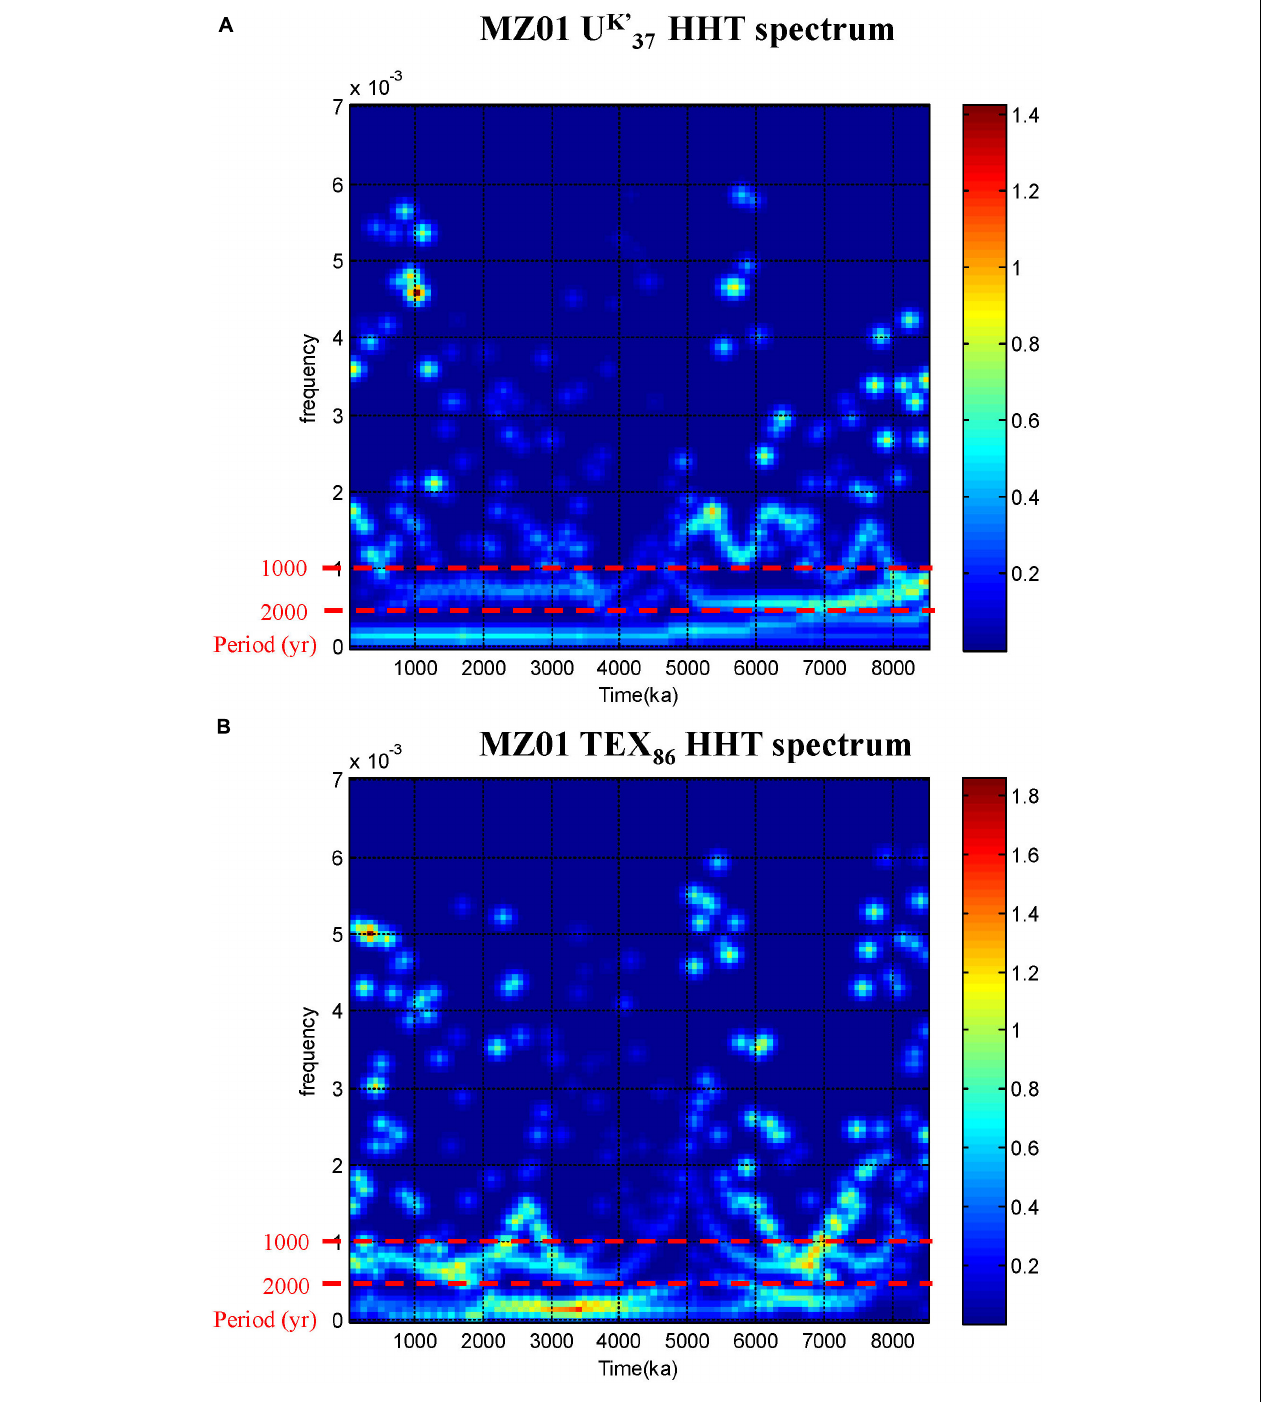
FIGURE 4 | HHT spectrum of MZ01 U K (cid:48) 37 SST (A) and TEX 86 -derived temperature (B) . The colors between the periodicities of 1000 to 2000 year shown by dash lines indicate the spectral power. We note that the interpretation on spectral power of < 1000–2000 year between ∼ 5–2.5 ka is uncertain due to very low sedimentation rate of core